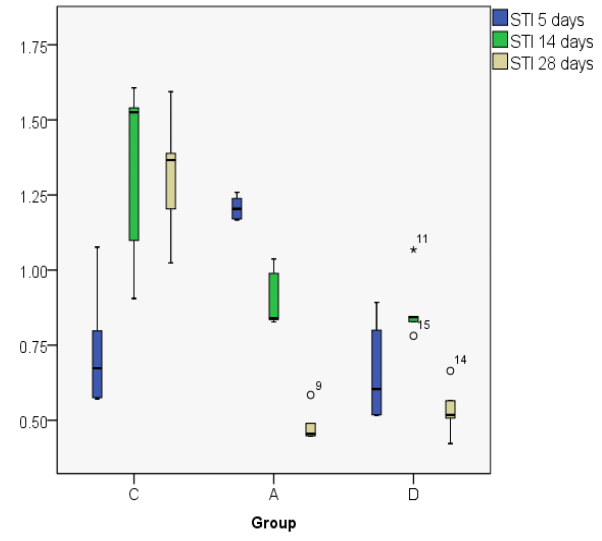
Figure 13. Subepithelial thickness index (STI) value distribution (boxplot representation).